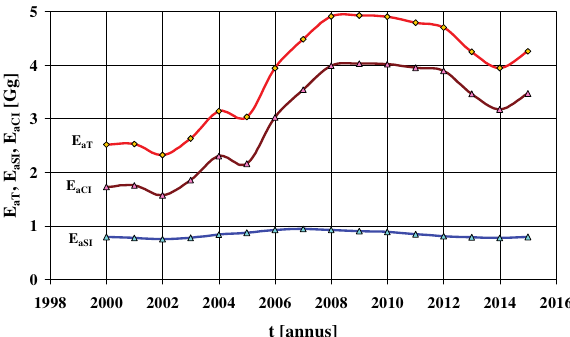
Fig. 15. National annual emission of carbon dioxide from passenger cars